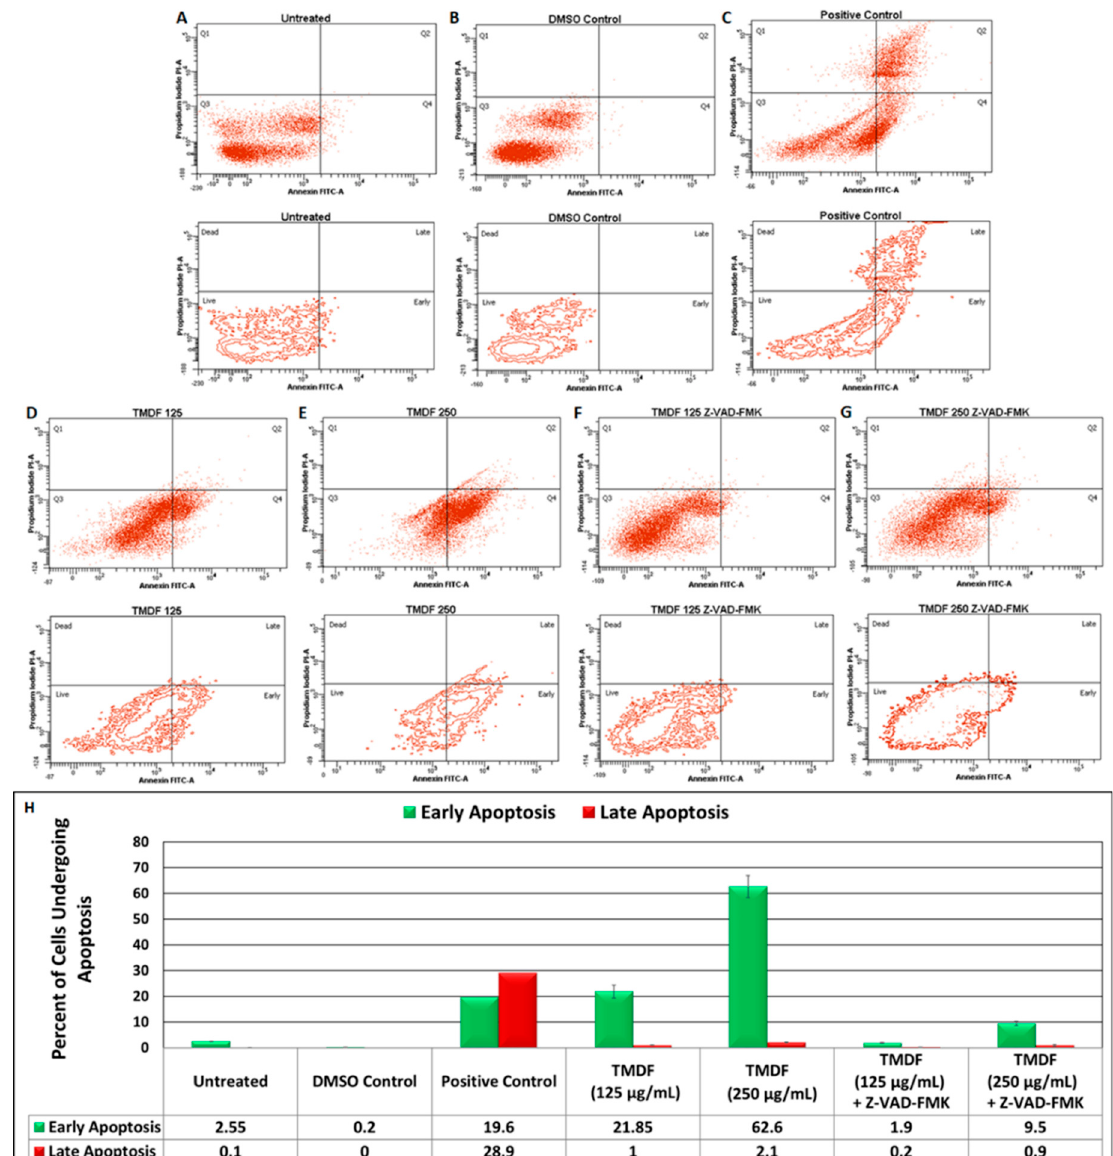
Figure 3. Flow cytometric analysis of Annexin V and propidium iodide-stained MCF-7 cells treated with dichloromethane fraction of T. mascatense (TMDF). MCF-7 cells were treated with 125 and 250 µg/mL of TMDF for six hours. ( A ) Untreated cells; ( B ) DMSO control; ( C ) Cells treated with Boswellia sacra , a known inducer of apoptosis (positive control) [52]; ( D ) Cells treated with 125 µg/mL of TMDF; ( E ) Cells treated with 250 µg/mL of TMDF; ( F ) Cells pretreated with 20 µM of Z-VAD-FMK followed by six hour treatment with 125 µg/mL of TMDF; ( G ) Cells pre-treated with 20 µM of Z-VAD-FMK followed by six hour treatment with 250 µg/mL of TMDF. ( H ) Column graph that plots the percentage of cells that shift into the early (green bars) and late (red bars) of apoptosis upon the various treatments mentioned above. The “DMSO control” sample contains the same amount of DMSO as present in the 250 µg/mL sample of TMDF.